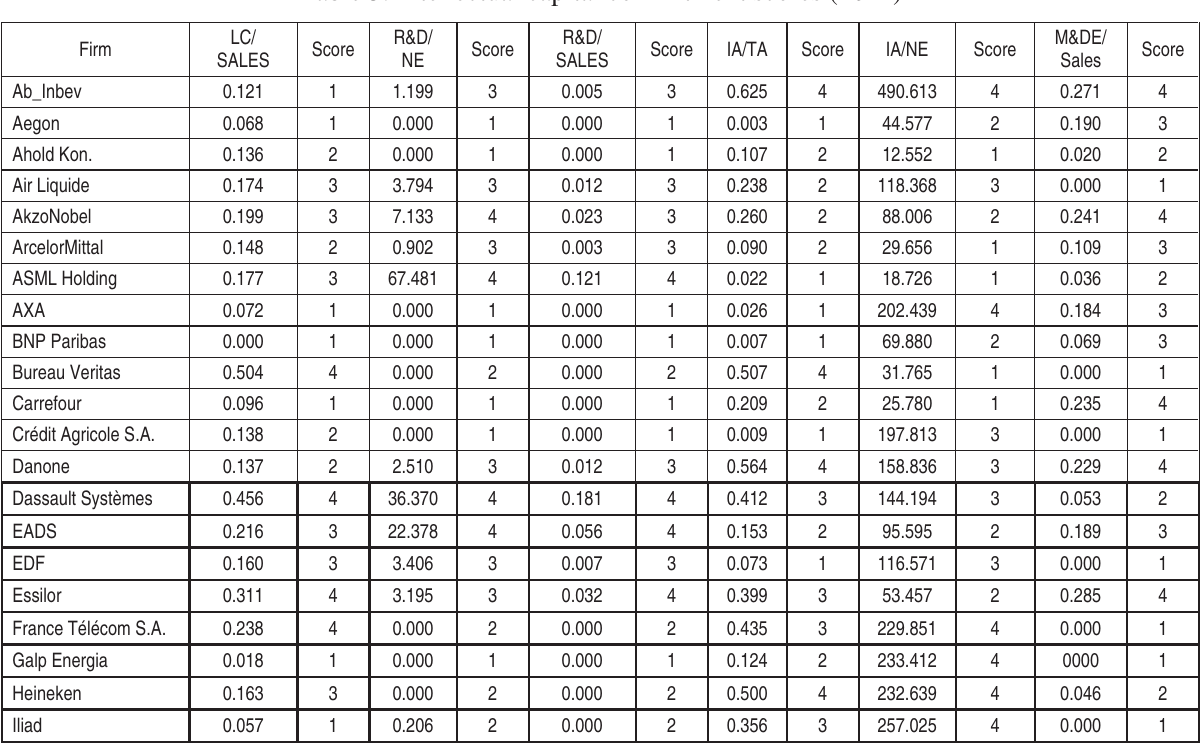
Table 3. Intellectual capital commitment scores